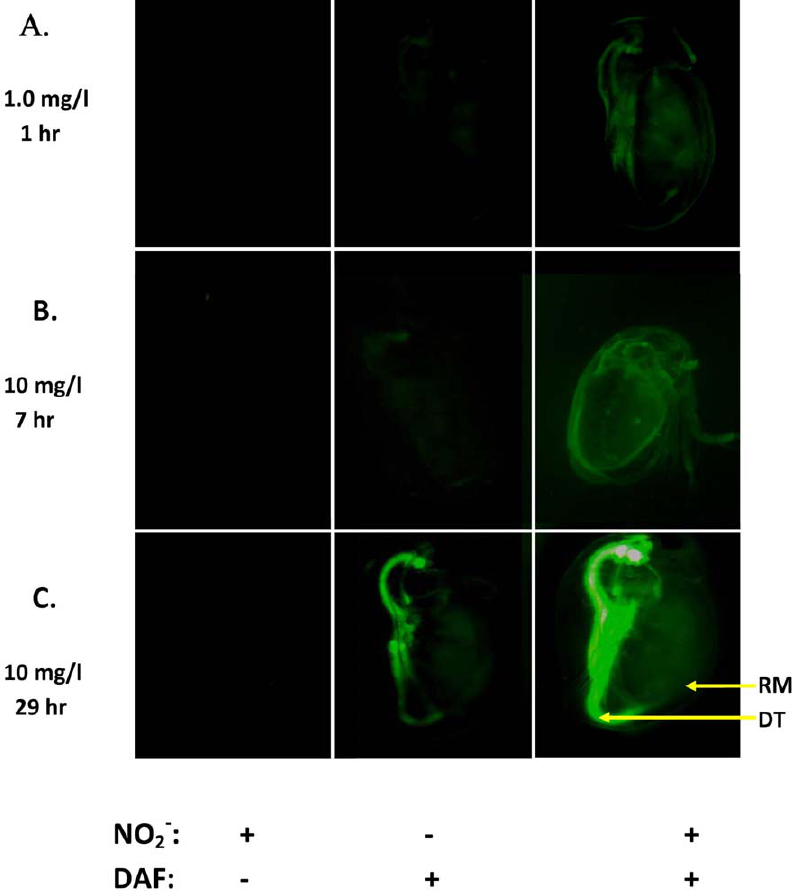
Figure 3. Nitric oxide accumulation in NO 2 2 -exposed perinatal daphnids as indicated by trapping and fluorescent visualization with diacetylaminofluorocene (DAF, 10 m M). NO 2 2 exposure concentration (as mg N/l) and duration of exposure are presented to the left of each row of images. DT and RM denote the digestive tract and respiratory membranes, respectively.